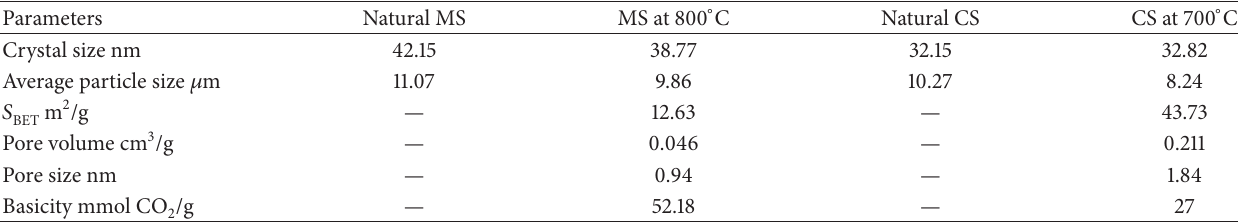
Table 1: Some characteristics of the prepared biocatalysts.